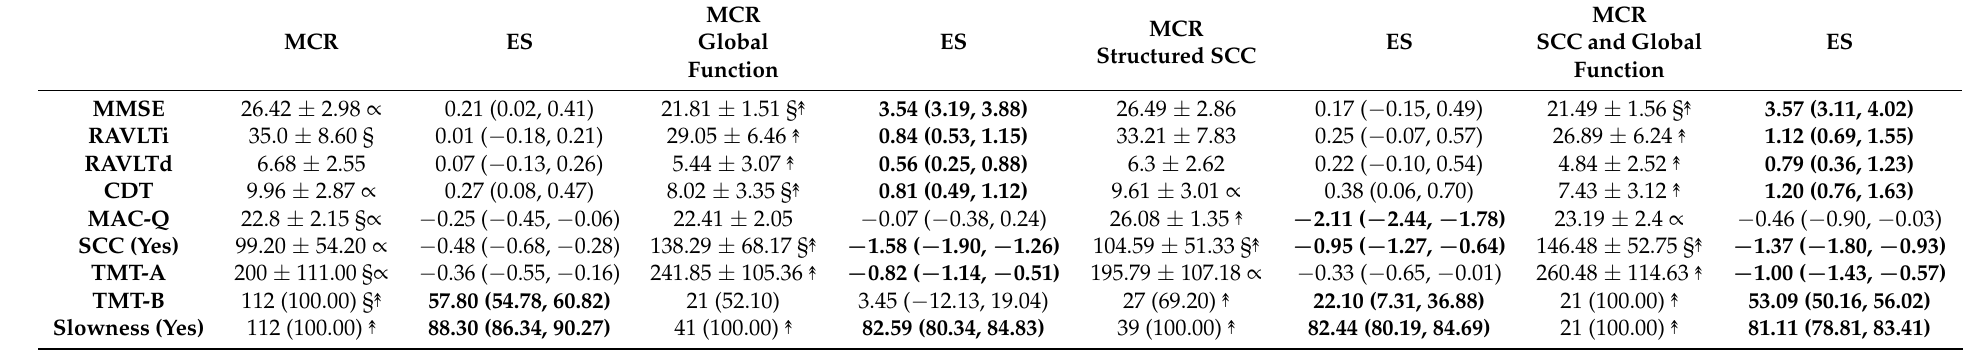
Table 2. Cognitive and physical profiles of MCR subtypes * (N: 1138). Table 1. Clinical characteristics of MCR subtypes * (N: 1138). Table 1. Clinical characteristics of MCR subtypes * (N: 1138). Table 1. Clinical characteristics of MCR subtypes * (N: 1138). Table 1. Clinical characteristics of MCR subtypes * (N: 1138). Table 1. Clinical characteristics of MCR subtypes * (N: 1138). Table 1. Clinical characteristics of MCR subtypes * (N: 1138). Table 1. Clinical characteristics of MCR subtypes * (N: 1138). Table 1. Clinical characteristics of MCR subtypes * (N: 1138). Table 1. Clinical characteristics of MCR subtypes * (N: 1138). Table 1. Clinical characteristics of MCR subtypes * (N: 1138). Table 1. Clinical characteristics of MCR subtypes * (N: 1138). Table 1. Clinical characteristics of MCR subtypes * (N: 1138). Table 1. Clinical characteristics of MCR subtypes * (N: 1138). Table 1. Clinical characteristics of MCR subtypes * (N: 1138). Table 1. Clinical characteristics of MCR subtypes * (N: 1138). Table 1. Clinical characteristics of MCR subtypes * (N: 1138). Table 1. Clinical characteristics of MCR subtypes * (N: 1138). Table 1. Clinical characteristics of MCR subtypes * (N: 1138). Table 1. Clinical characteristics of MCR subtypes * (N: 1138). Table 1. Clinical characteristics of MCR subtypes * (N: 1138). Table 1. Clinical characteristics of MCR subtypes * (N: 1138). Table 1. Clinical characteristics of MCR subtypes * (N: 1138).